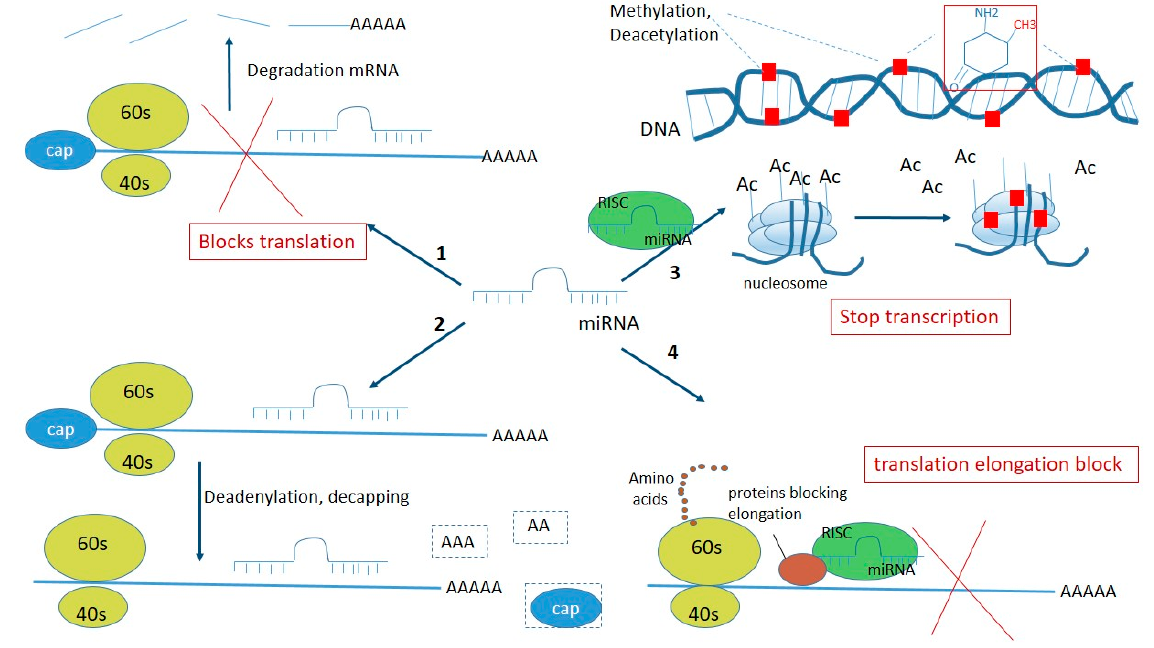
Figure 2. Scheme of inhibition of gene expression by miRNA in several ways (description in the article). Ac—acetyl, CH 3 CO.